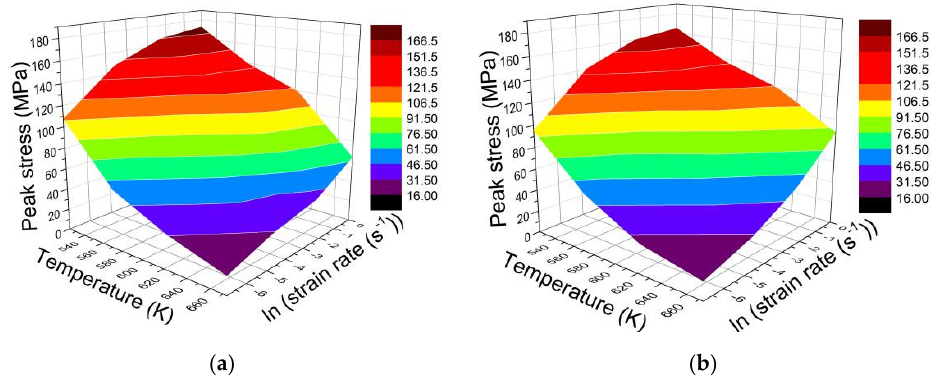
Figure 3. Variation of peak stresses of MZC ( a ) and MZCM ( b ) at different temperatures and strain rates.